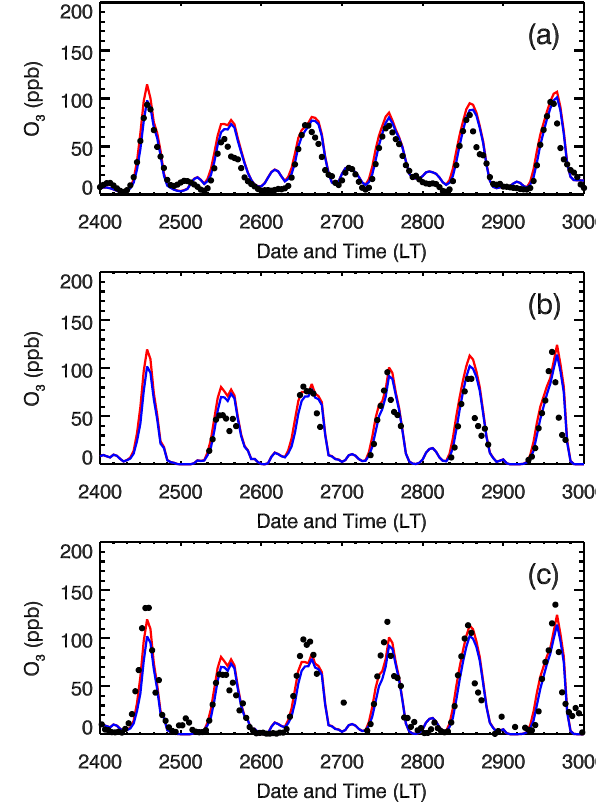
Fig. 7. Simulated and observed (a) NO and (b) , (c) NO 2 at T0 dur- ing the 24–29 March, 2006. The black dots denote the observation and the red and blue lines represent the simulations in the E-case and H-case, respectively. NO 2 measurement in (b) is from Chemi- luminescence and (c) is from LP-DOAS.